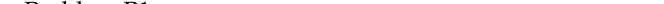
Algorithm 1 Algorithm for Problem